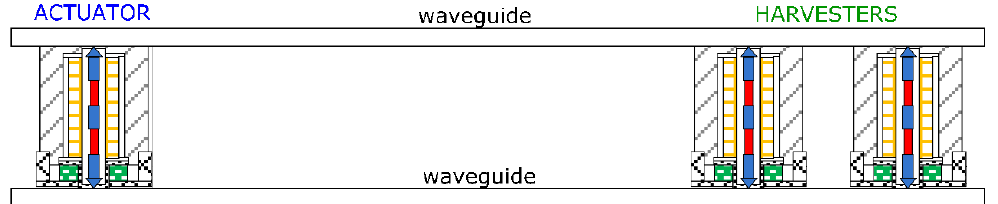
Figure 7. Actuator–harvester magnetostrictive system based on two Figure 7. Actuator – harvester magnetostrictive system based on two beams.